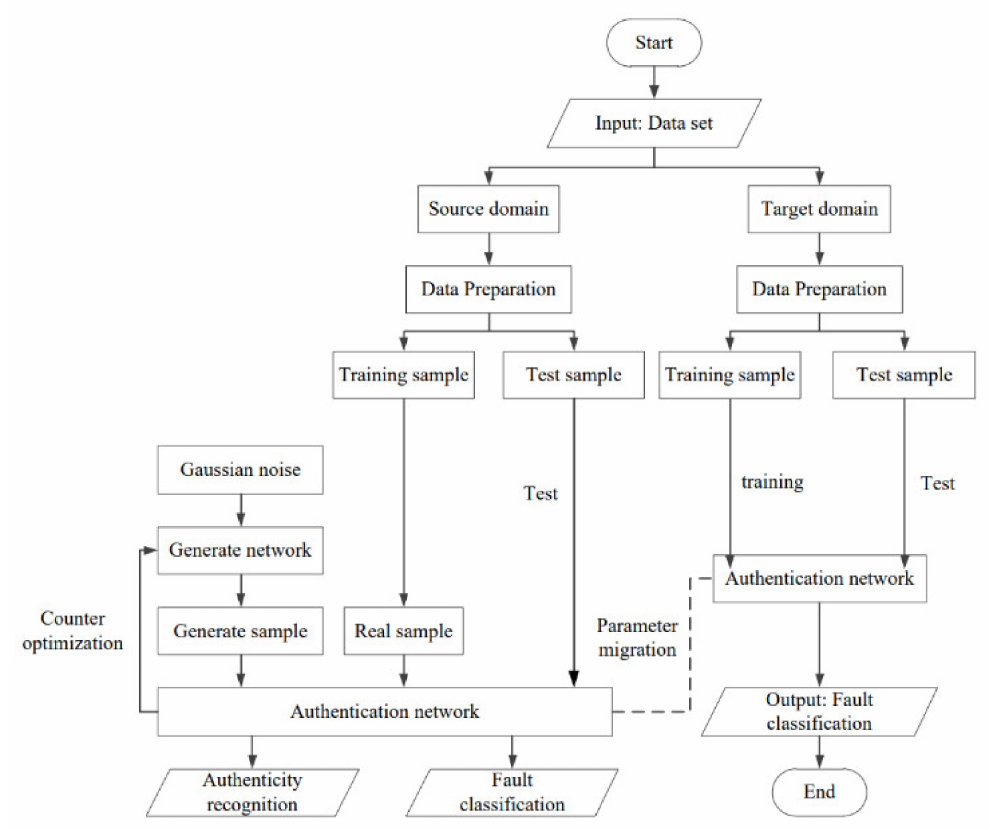
Figure 1. The framework of the proposed